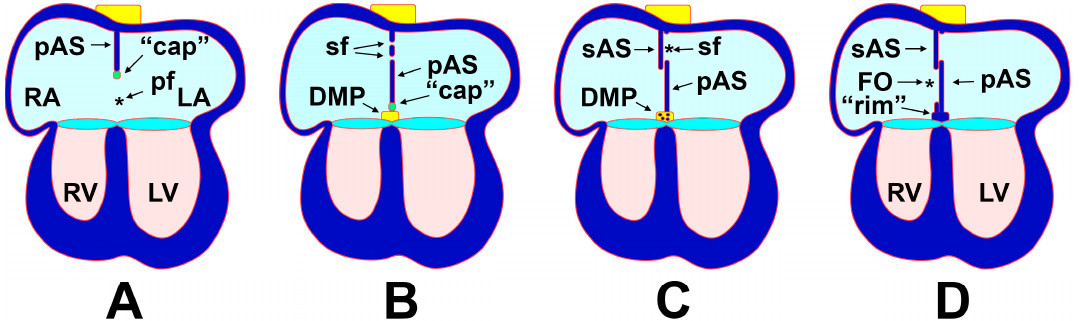
Figure 4. Atrial septation. This cartoon depicts the developmental events responsible for the formation of the atrial septal complex (see text). The yellow box in the back of the heart represents the posterior Second Heart Field giving rise to the DMP which in turn develops into the base of the atrial septal complexand becomes muscularized to form the muscular rim ( B – D ). The asterisk in ( A ) marks the primary foramen (also known as ostium primum); the asterisk in ( C ) marks the secondary interatrial foramen (also known as ostium secundum), which forms as a result of perforations in the upper part of the primary atrial septum (see ( B )). DMP = dorsal mesenchymal protrusion, pf = primary foramen, FO = foramen ovale, LA = left atrium, LV = left ventricle, PAS = primary atrial septum, RA = right atrium, RV = right ventricle, “rim” = myocardial rim, sAS = secondary atrial septum.